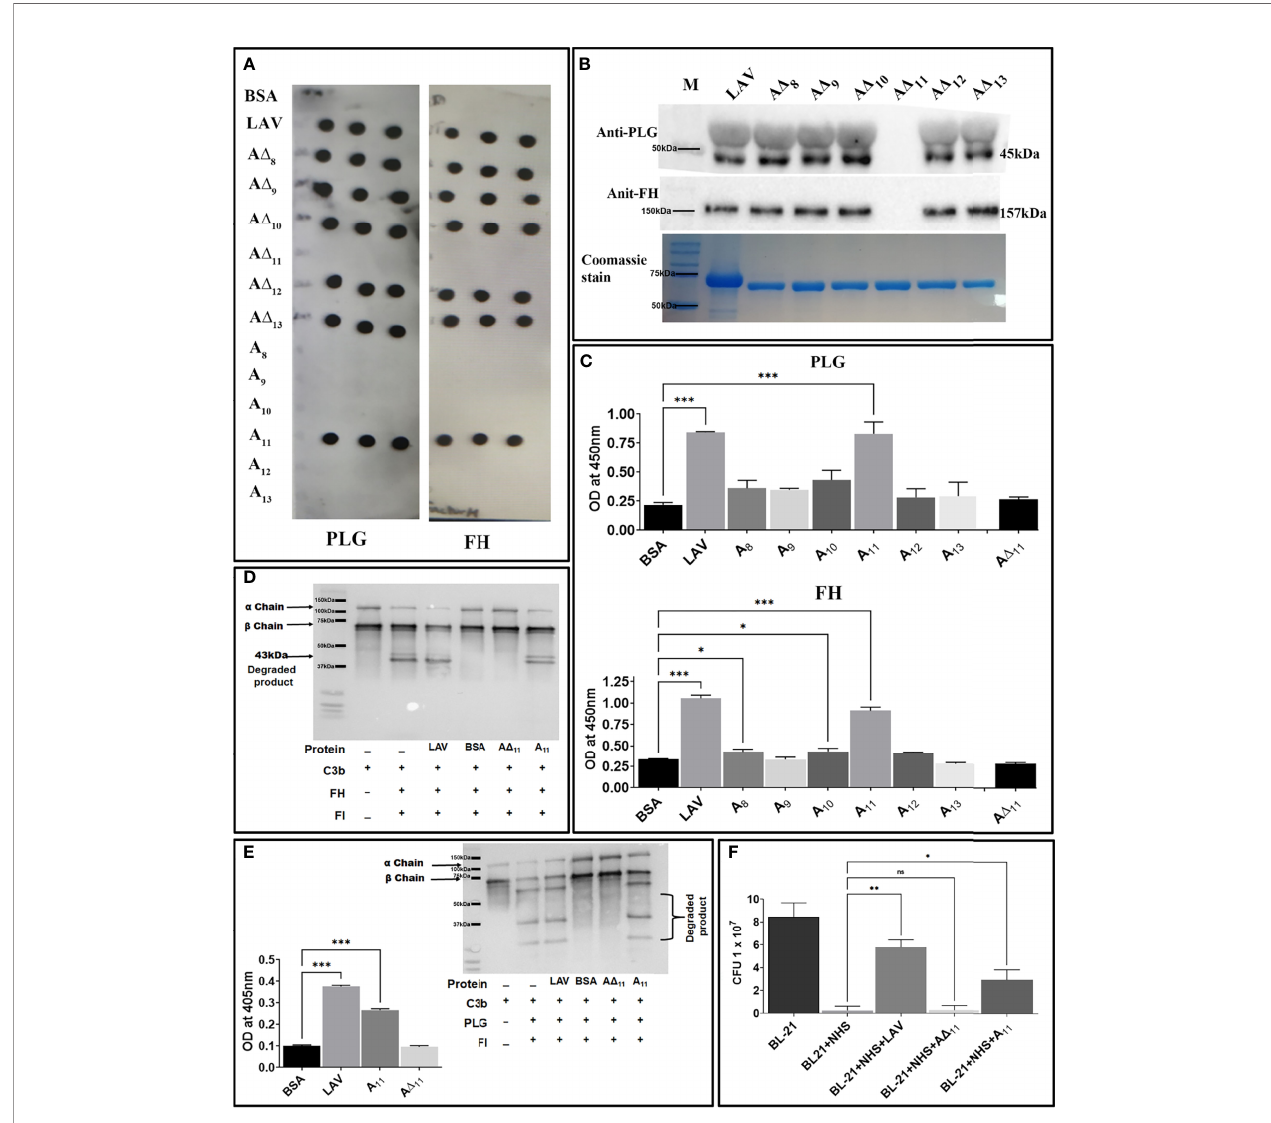
FIGURE 5 | Characterization of the domain of LAV involved in evasion from complement-mediated killing. (A) Binding of LAV domains as analyzed by Dot blot. Puri fi ed proteins LAV (positive control), BSA (negative control), individual domains (A 8 -A 13 ), and corresponding deletion mutants (A Δ 8 -A Δ 13 ) were immobilized on nitrocellulose membranes and then incubated with 1% NHS (as a source of FH and PLG). FH and PLG were detected with speci fi c antibodies by Western blot. (B) Binding of LAV deletion mutants as analysed by Pull down assay . Bead bound LAV deletion mutants (A Δ 8 -A Δ 13 ) were incubated with 10% HI NHS and protein – protein interaction was detected by western blot using Anti FH (157 kDa) or PLG antibody (45 kDa) as described in methodology (C) Binding of LAV domains as analyzed by ELISA. Microtiter plates were coated with 1µg of proteins LAV, domains (A 8 -A 13 ), and corresponding deletion mutants (A Δ 8 - A Δ 13 ) and 10% HI-NHS was added to each well. The binding was detected with speci fi c antibodies against FH and PLG as described in materials and methods. (D) Co-factor activity. LAV, A 11, A Δ 11 (2 m g/ml), and BSA (2µg/well) were immobilized on microtiter plates and incubated with puri fi ed FH. After washing, C3b and factor I (FI) were added, and the plate was incubated for 4h at 37°C. The products were analysed by SDS-PAGE, and the cleavage fragments of C3b was detected by Western blot using anti-human C3 polyclonal antibodies as described in materials and methods. (E) Plasmin activity. LAV, A 11, A Δ 11 (2 m g/ml), and BSA (2µg/well) were immobilized on microtiter plates followed by the addition of PLG, uPA, and speci fi c plasmin substrate. The plate was incubated for 48h, and absorbance was read at 405nm as described in materials and methods. In another experiment, C3b was incubated with activated plasmin in the presence or absence of A 11 and cleavage products were visualized using Western blot. (F) Bactericidal assay. 1.3 × 10 8 E. coli BL-21 (DE3) cells were incubated with 10 % NHS with or without pre-incubation with A 11 or A Δ 11 or LAV at 20 m g/ml for 30 min at 37 °C. The samples were plated on LB agar plates and incubated at 37°C overnight. Survival was determined by counting bacterial colonies the following day. All data are representative of three independent experiments. Signi fi cant differences were calculated using the one or two way ANOVA (***, **, *, ns indicates P < 0.01, P < 0.01, P < 0.05 and non-signi fi cant